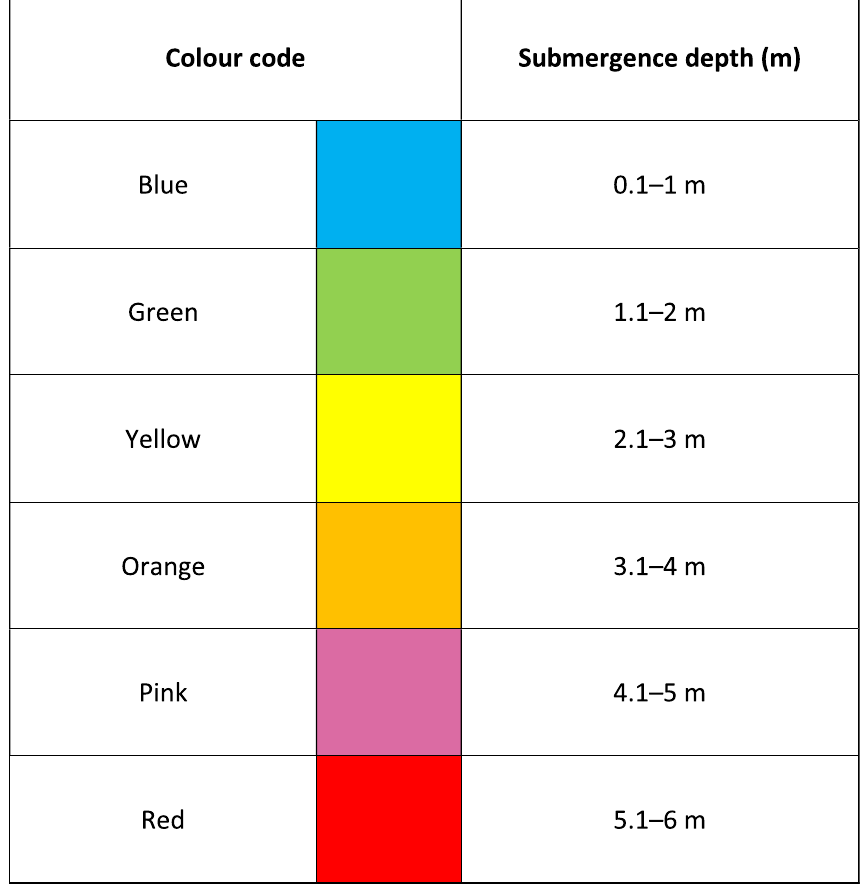
Table 8 Colour code of submergence